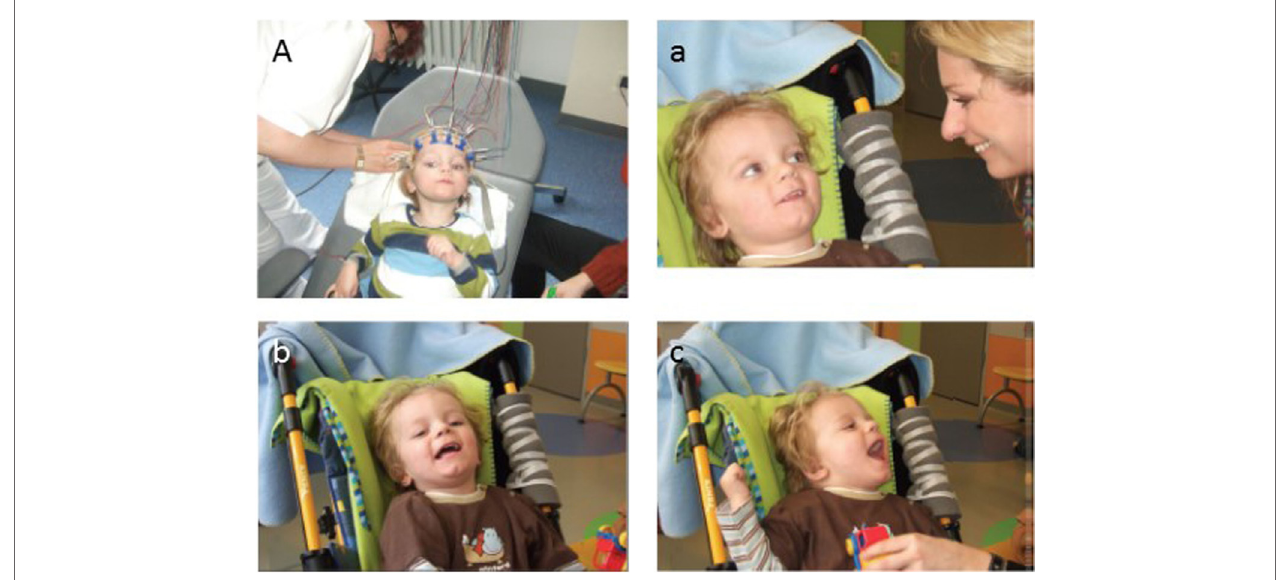
FiGURe 2 | The patient (L.B.) before and after autologous umbilical cord blood transplantation . (A) The patient during EEG recording is in a VS 9 weeks after the insult before transplantation of cord blood cells. Note the dilated, unresponsive pupils in spite of bright light from the ceiling. (a–c) Two-month follow-up. (a) First social smiling of the patient (L.B.) toward his mother and (b,c) laughing, when played with, 2 months after transplantation of cord blood cells (i.e., 4 months and 1 week after severe brain damage caused by cardiac arrest). Reproduced from Jensen and Hamelmann (58) with